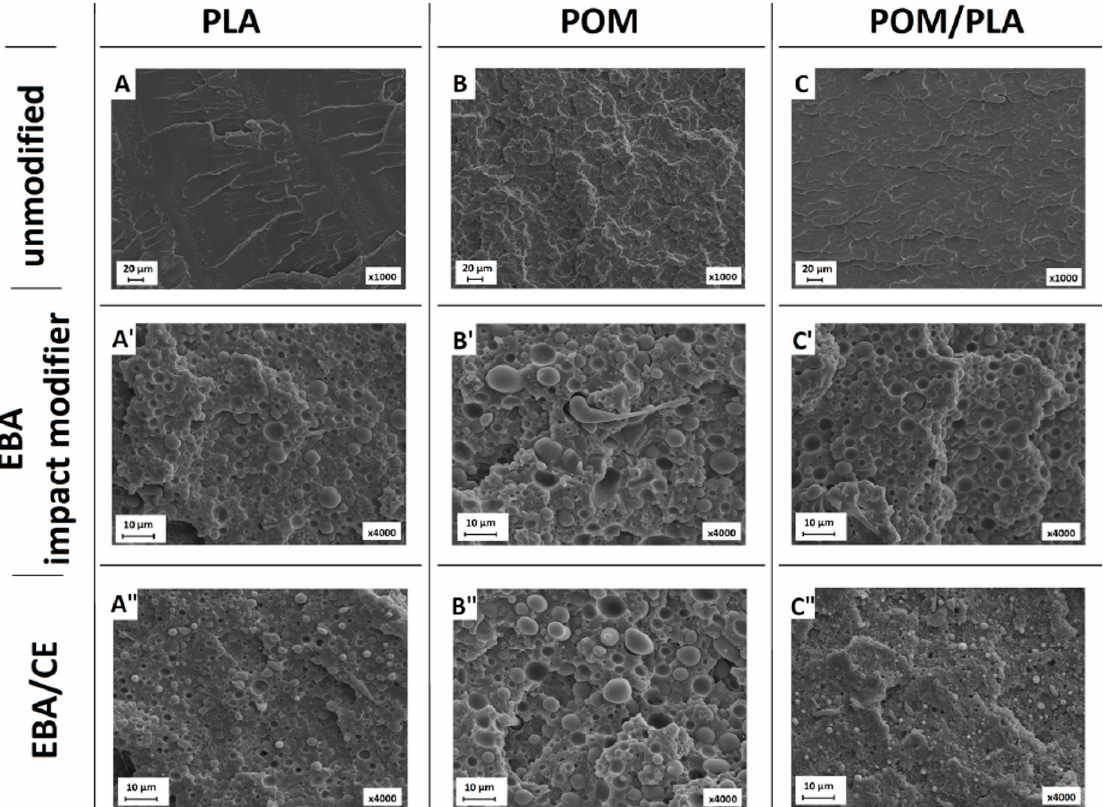
Figure 10. Micrographs presenting the cryo-fracture surfaces of the PLA- ( A , A’ , A” ), POM- ( B , B’ , B” ), and POM/PLA- ( C , C’ , C” ) based samples. Subsequent rows indicate the presence of the unmodified samples (top), EBA-modified samples (middle), and EBA/CE-system-modified blends (bottom).